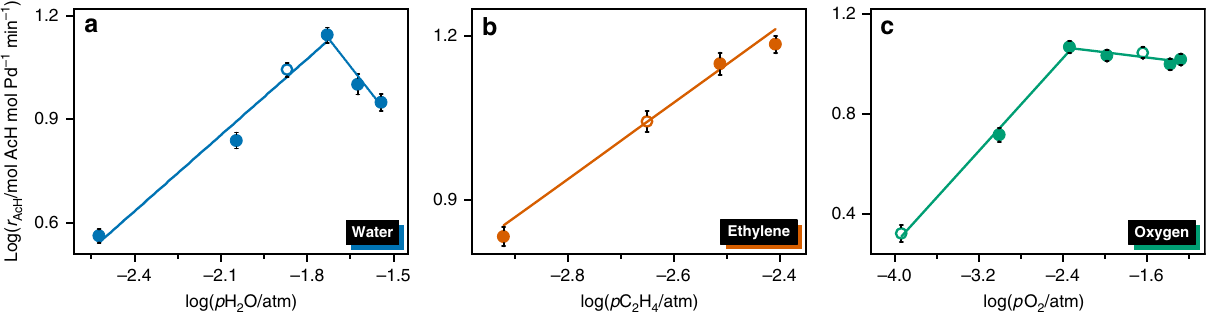
Fig. 1 Kinetics of Wacker oxidation over Pd1Cu5-Y. Double-logarithmic plots of the dependence of the rate of acetaldehyde ( r AcH ) formation on varying reactant partial pressures of a water, b ethylene, and c oxygen over Pd1Cu5-Y. The partial pressure of helium was adjusted so that the contact time does not vary. Hollow points in a and b correspond to the partial pressure values used in the standard Wacker conditions. Hollow points in c show the partial pressure values used in the transient measurements done in time-resolved XAS. The error bars in a – c indicate the standard deviation ( n = 3